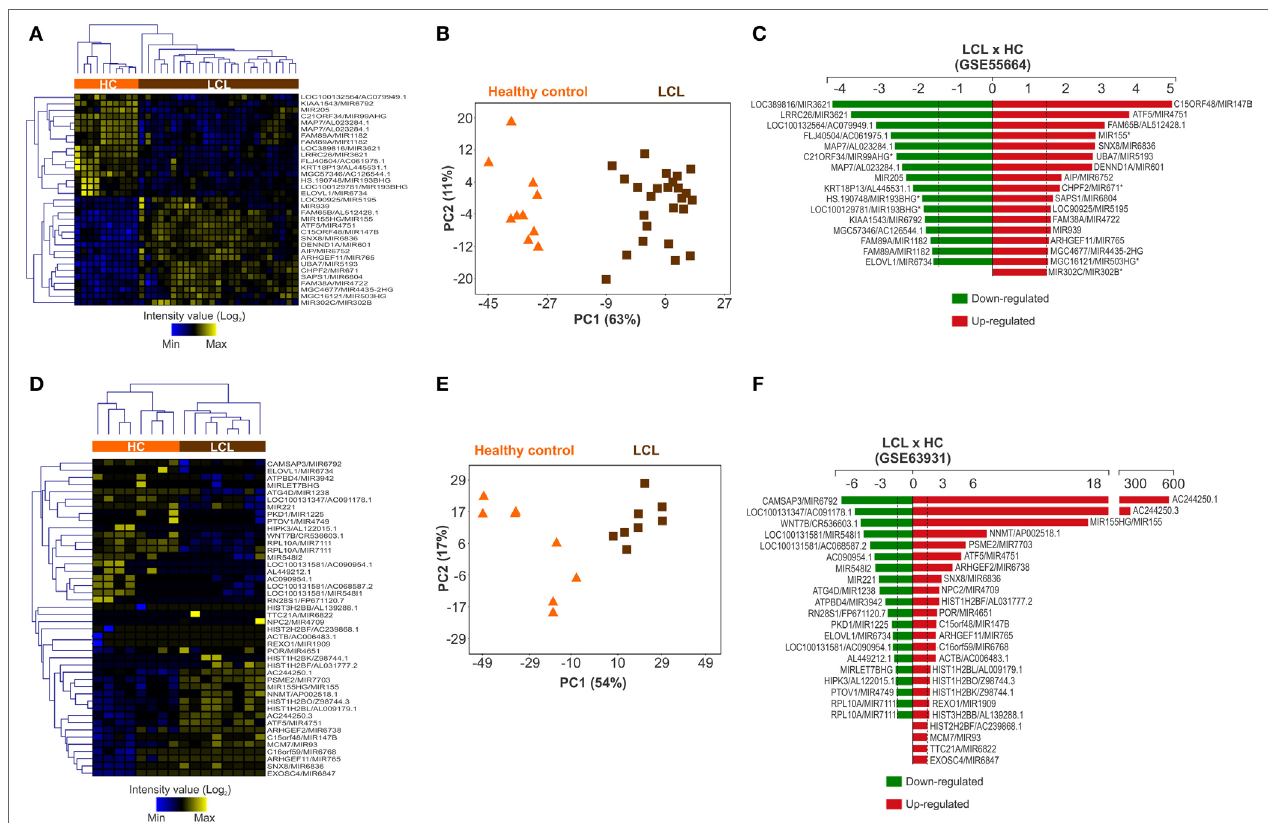
FigUre 1 | Expression profile of microRNAs is altered during cutaneous leishmaniasis caused by L. braziliensis . MicroRNA probes that were differentially expressed ( p < 0.05 and − 1.5 < fold change > 1.5) between healthy control (HC; orange bar) and localized cutaneous leishmaniasis (LCL; brown bar) skin samples were included in this analysis. Heat maps showing the expression profile of (a) 33 microRNA probes from GSE55664 and (B) 44 microRNA probes from GSE63931. Rows represent microRNA probes and columns represent samples. Unsupervised hierarchical clustering of the samples was performed using the Euclidean distance method; Principal Component Analysis using microRNA probes that were differentially expressed between the HC and LCL skin samples were conducted for (c) GSE55664 or (D) GSE63931 data sets. Each symbol represents one sample; fold changes of microRNA probes modulated in LCL relative to HC samples are shown for (e) GSE55664 and (F) GSE63931 data